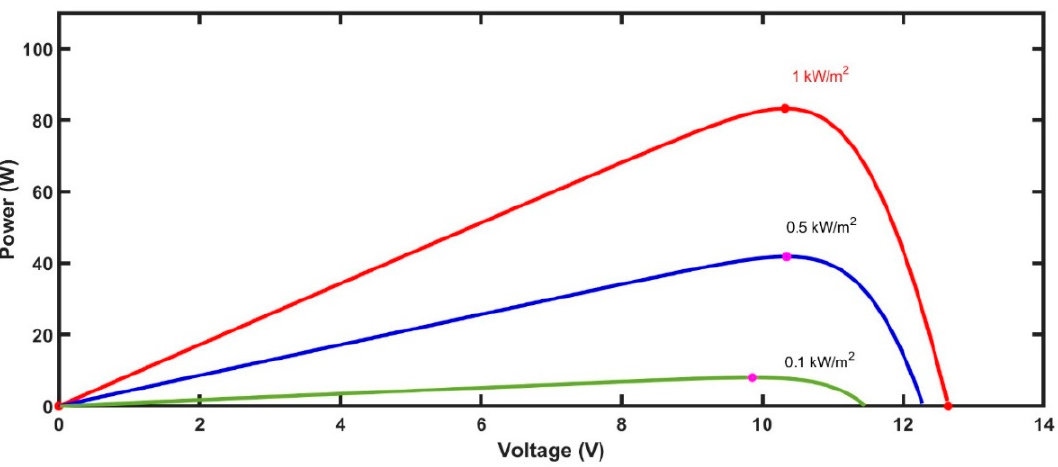
Figure 3. Slope variation and steady-state performance.